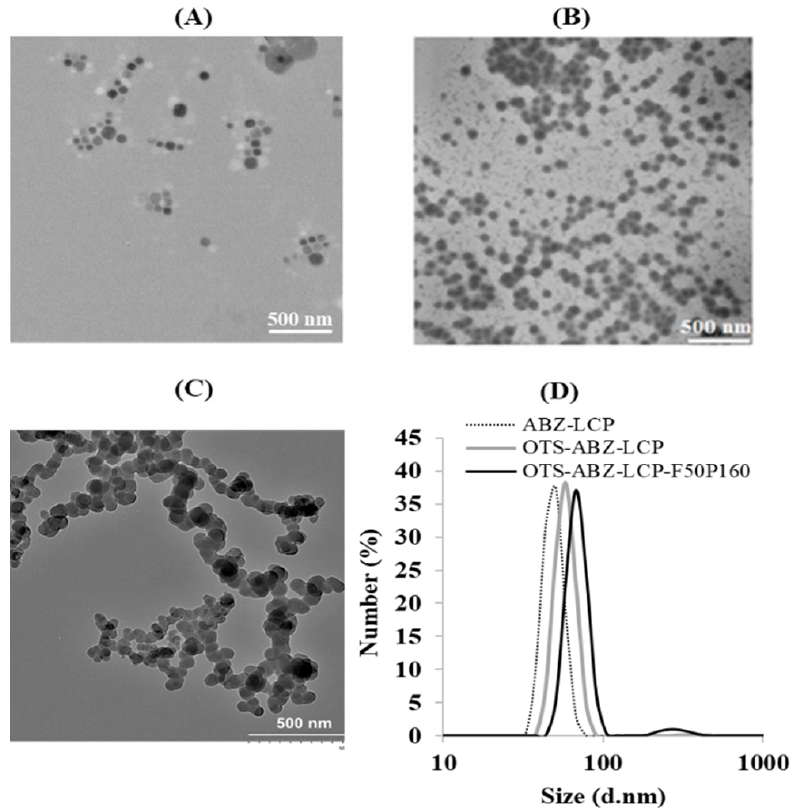
Figure 1. Characteristics of LCP nanoparticles . TEM images of ( A ) ABZ-LCP; ( B ) OTS-ABZ-LCP; and ( C ) OTS-ABZ-LCP-F100P160 (as a representative of dual targeting LCP with some aggregation after drying) NPs. ( D ) The size distribution of ABZ-LCP, OTS-ABZ-LCP and OTS-ABZ-LCP-F100P160 NPs (the minor peak at 300 nm may be NP aggregates).